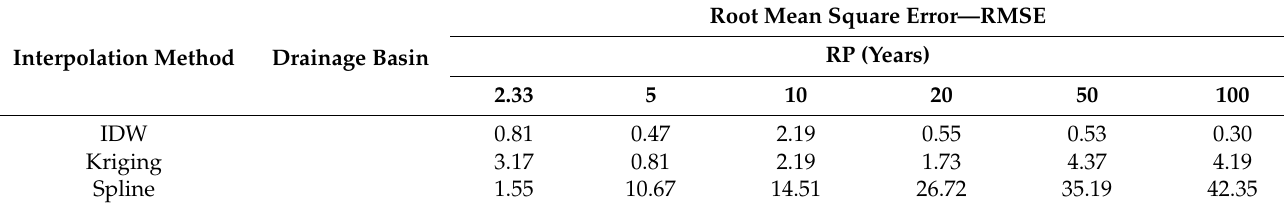
Table 7. Evaluation of interpolation methods in the different basins